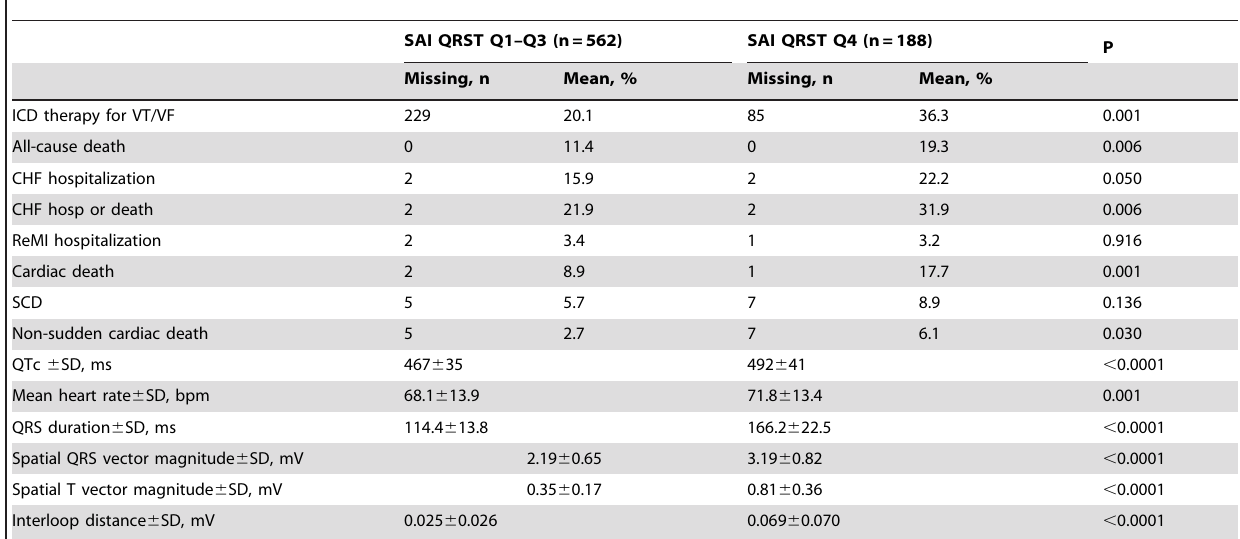
Table 2. Outcomes and baseline ECG parameters in patients with SAI QRST, dichotomized at the 75 th percentile ( . 334 mV*ms).